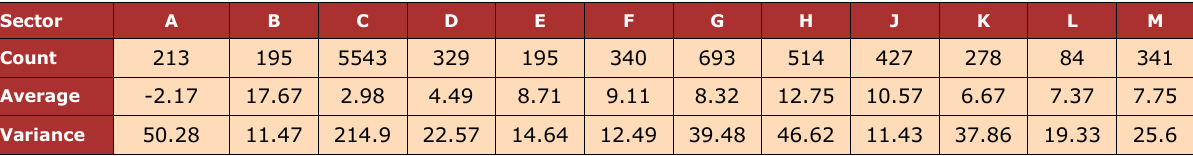
Table 1. All sectors of net assets yield comparison